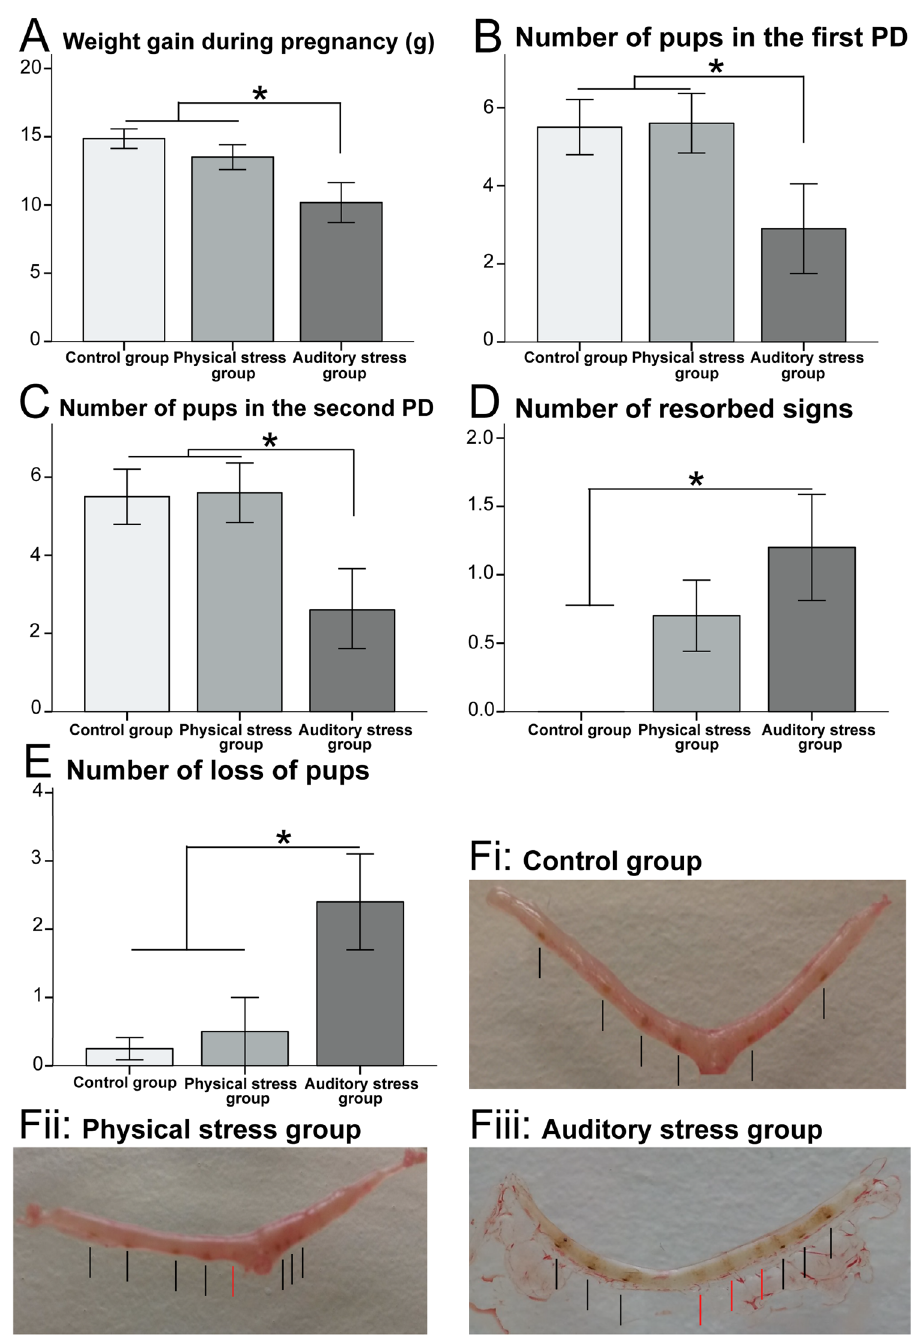
Figure 4. Pregnancy outcome: The auditory stress group obtained ( A ) lower weight gain during pregnancy (g), ( B ) decreased number of pups on the first postnatal day (PD), ( C ) fewer pups on the second PD, ( D ) higher number of resorbed signs, and ( E ) higher number of lost pups. N = 10 in all groups. Results are reported as mean ± S.E.M. Asterisks indicate * p < 0.05. Uterus receptivity : ( F ) A sample of marked uterus from each study group (fi = control, fii = physical stress, fiii = auditory stress). Black lines show the implantation sites and red lines show the resorbed